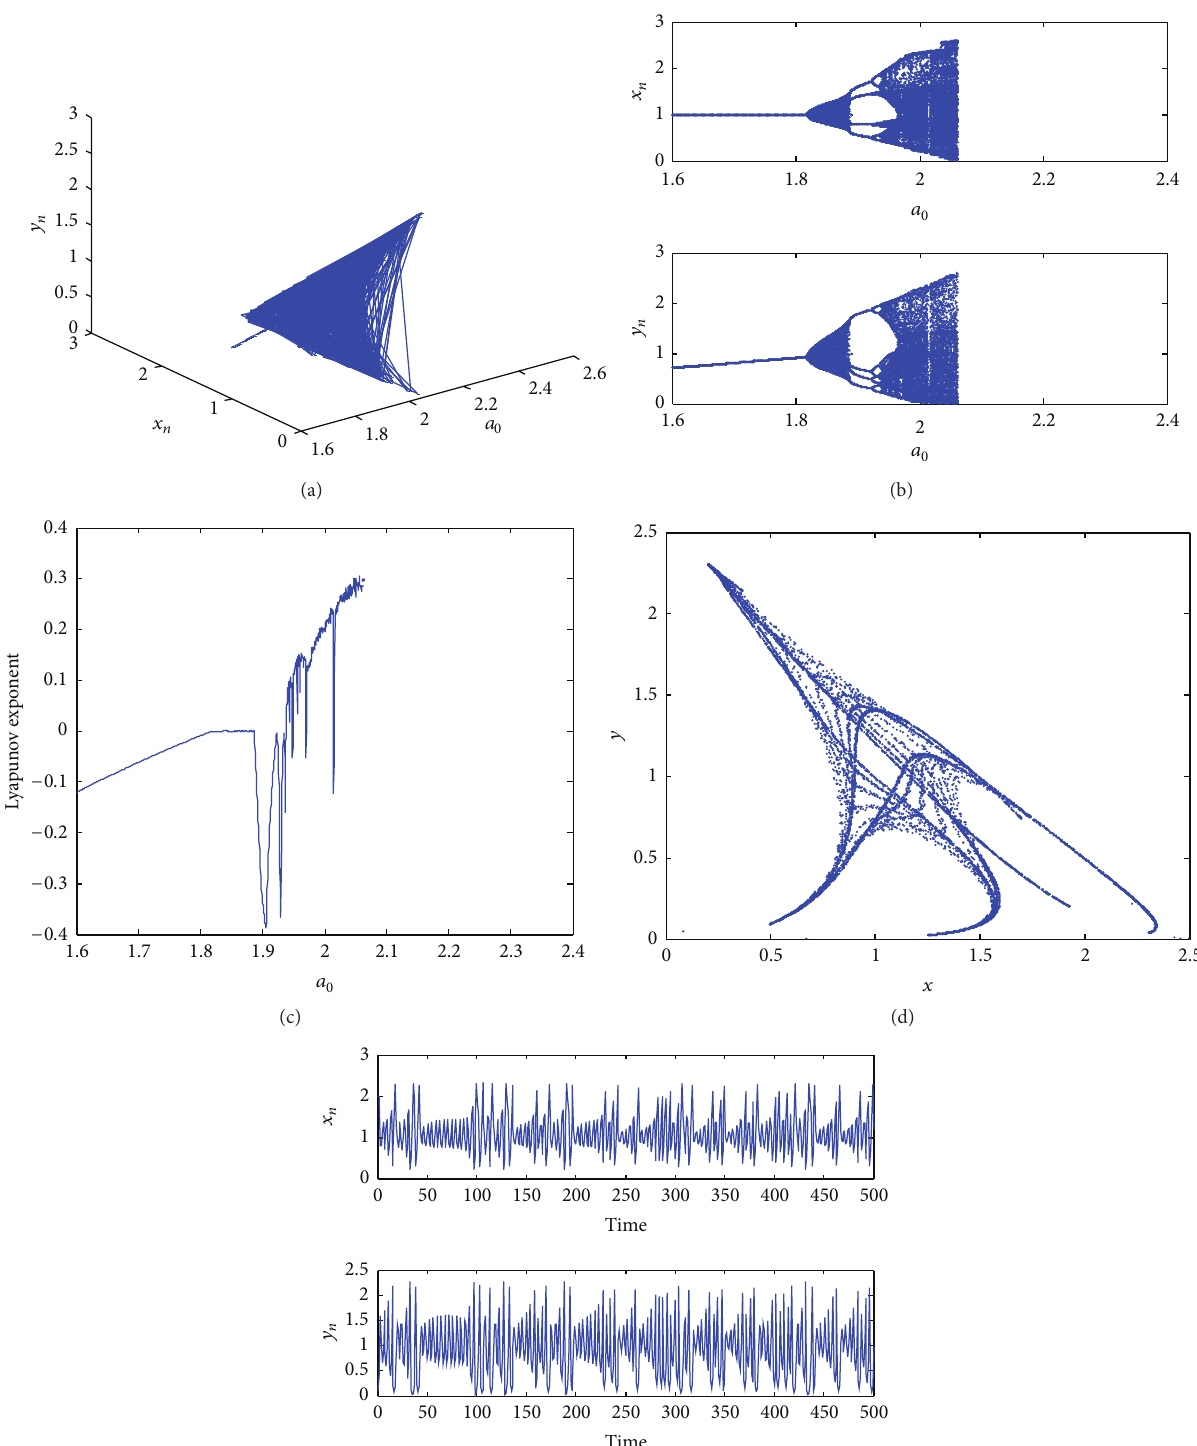
Figure1:(a)Bifurcationdiagramin (𝑎 0 ,𝑥 𝑛 , 𝑦 𝑛 ) space.(b)Thebifurcationdiagramin 𝑎 0 - 𝑥 𝑛 planeandin 𝑎 0 - 𝑦 𝑛 plane.(c)SpectrumofLyapunov exponents corresponding to (b). (d) The attractor of (5) with 𝑎 0 = 2 (e) Time series of 𝑥 𝑛 and 𝑦 𝑛 of the same